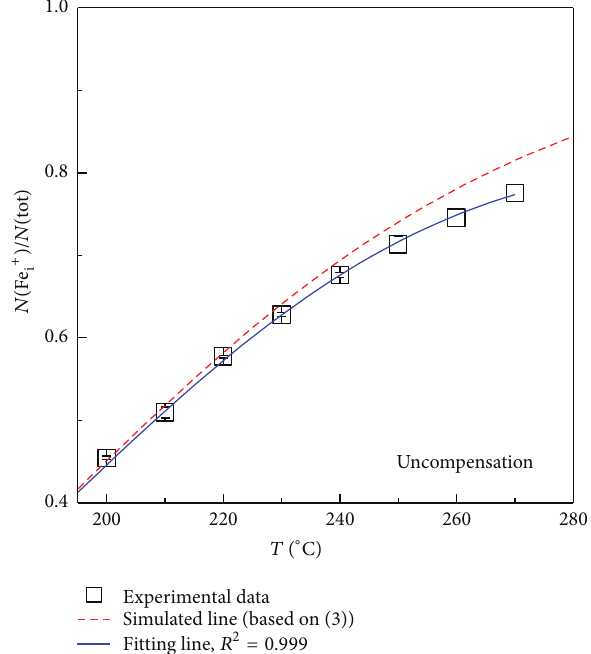
Figure 2: The ratio of N (Fe i + )/ N (tot) as a function of temperature for CZ-1 and CZ-2. Black squares and red circles refer to the CZ-1 and CZ-2 samples, respectively. The solid lines represent the best fits based on (3).